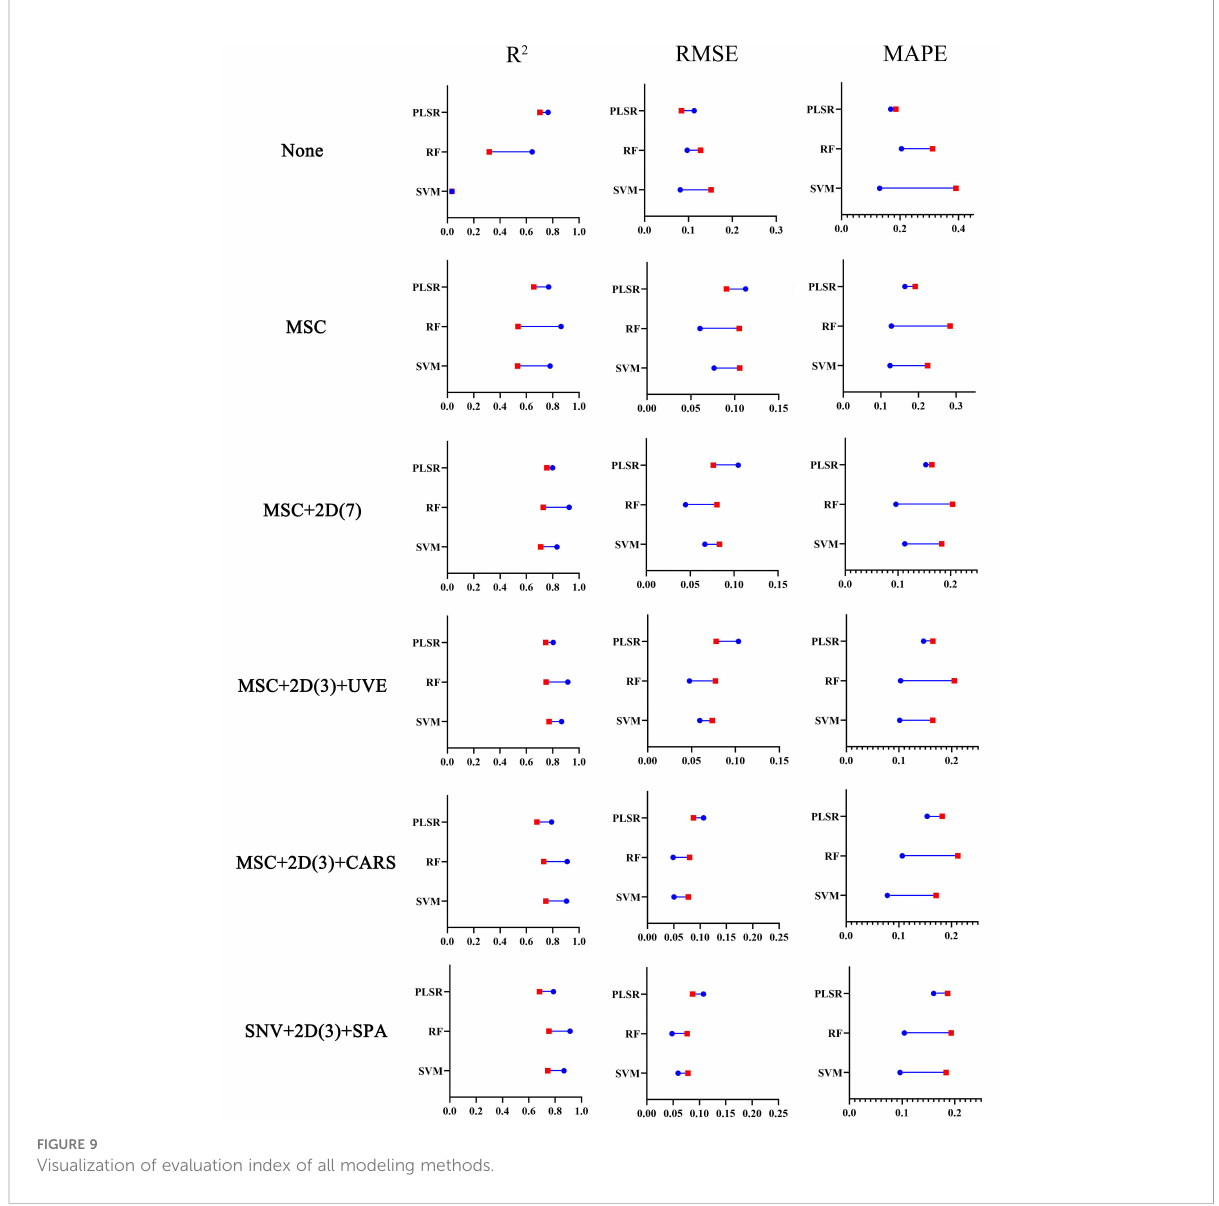
FIGURE 9 Visualization of evaluation index of all modeling methods.